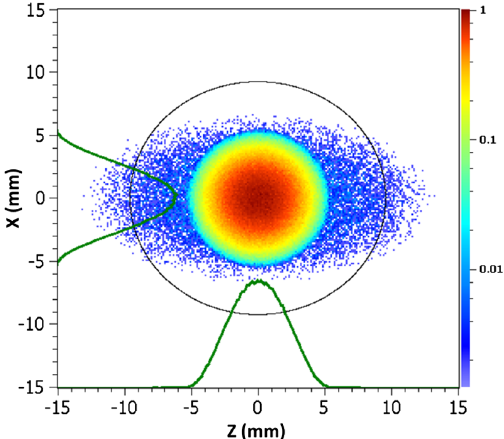
FIG. 2. Exemplary initial core-halo distribution in z (cid:1) x plane for halo multiplication factors M z =M x ¼ 6 = 1 : 5 , with ellipse including 99.9% of total